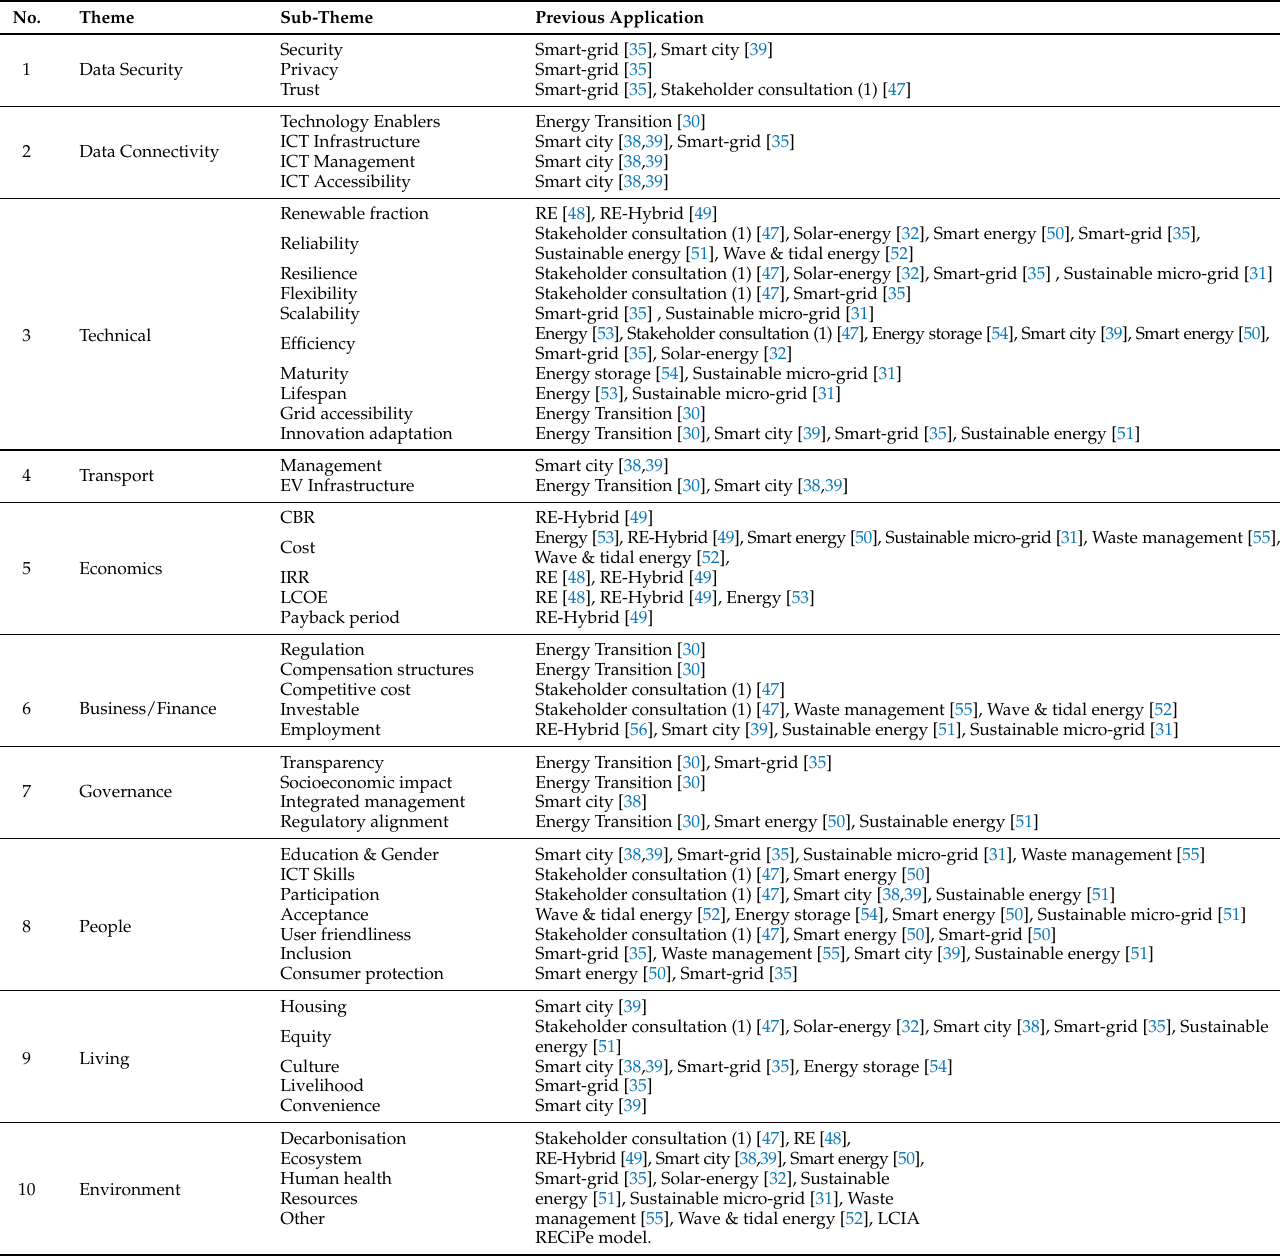
Table A1. Taxonomy for Smart Local Energy System